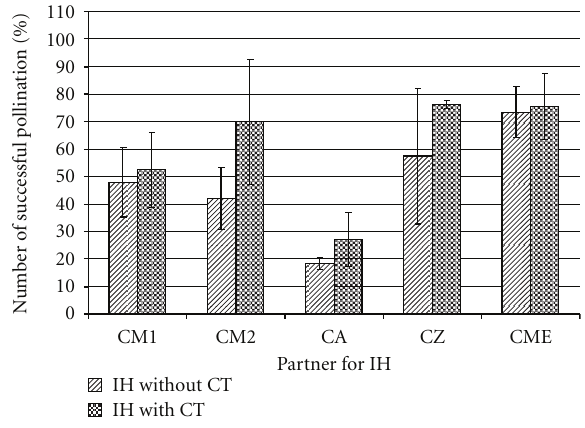
Figure 1: The comparison of successful pollination (% of obtained fruits) in interspecific hybridization between 2x cucumber (IH without CT) and 2x/4x cucumber plants (IH with CT) with other Cucumis spp. Abbreviations: CM1, CM2, CA, CZ, and CME: set of tested Cucumis spp., hybridization partners for cucumber; IH: interspecific hybridization; CT: colchicine treatment; Y-error bars represent standard deviations.